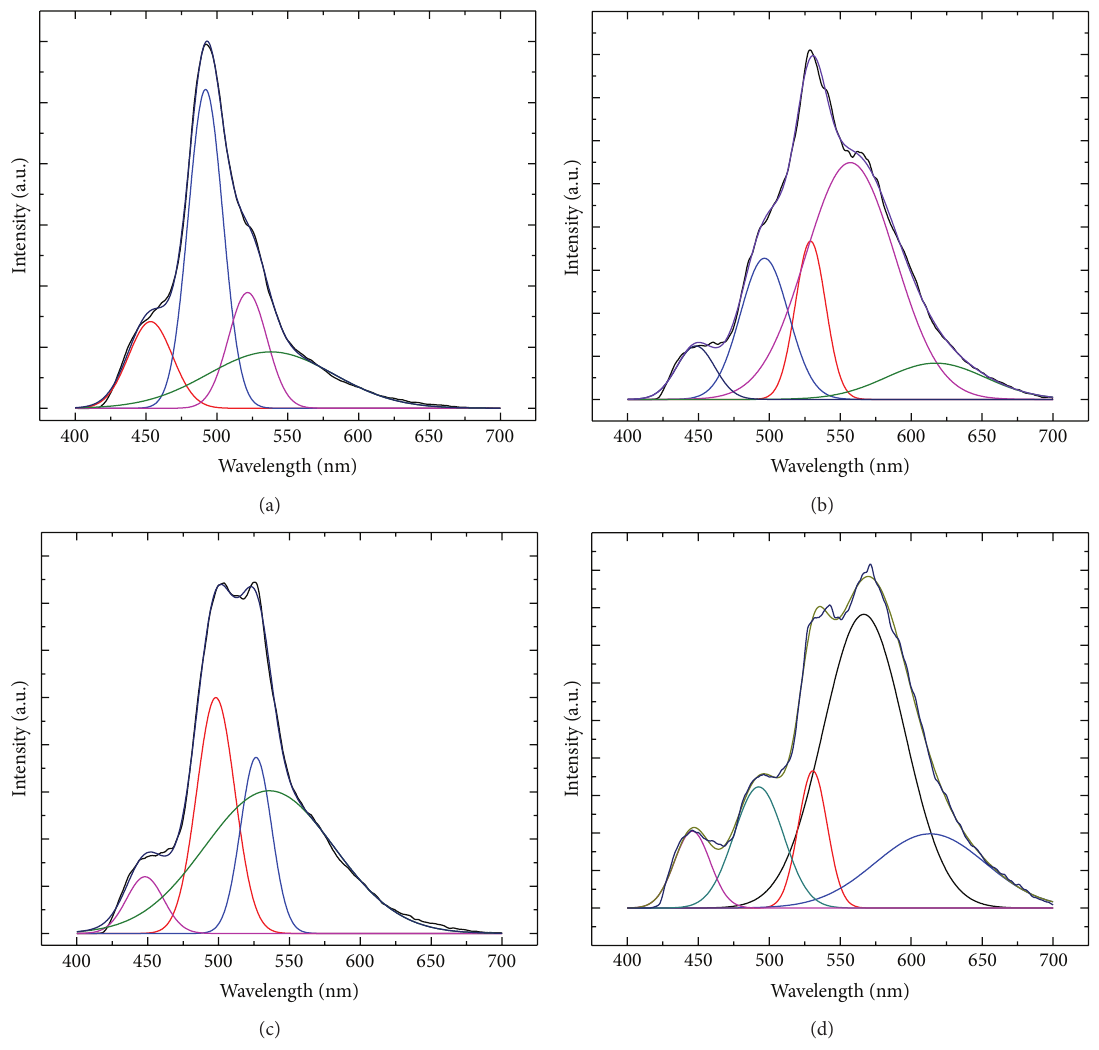
Figure 3: Photoluminiscent spectra of (a) CdS-n(TU) synthesized at 100 ∘ C for 30 min and CdS-n(TA) products synthesized at (b) 100 ∘ C, (c) 50 ∘ C, and (d) 150 ∘ C for 30